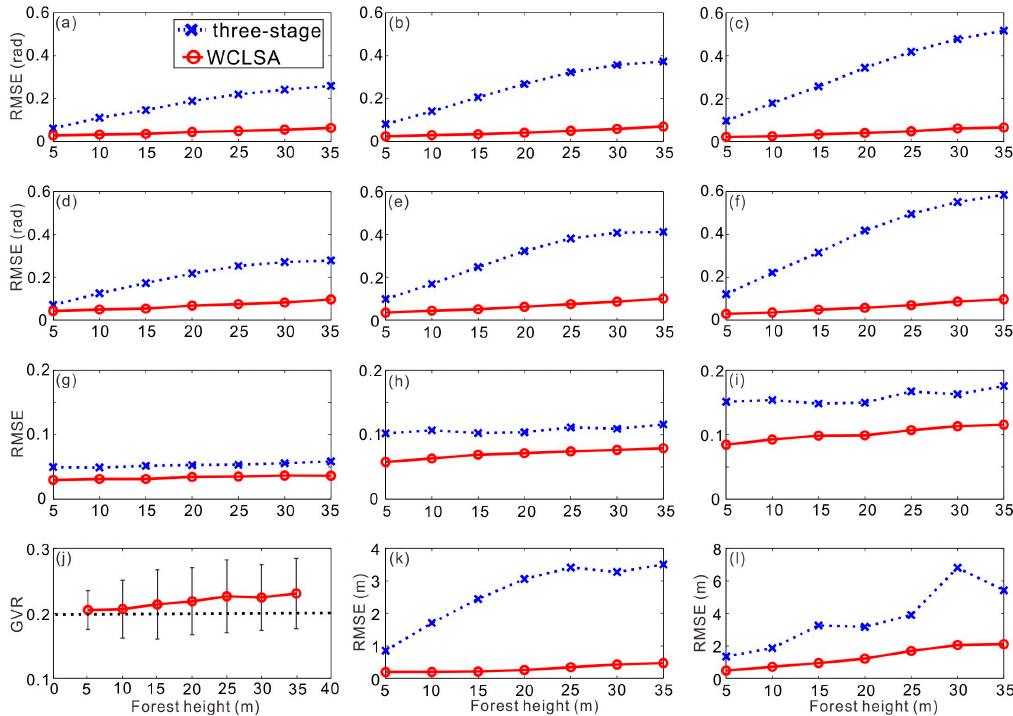
Figure 4. Solutions derived by three-stage and WCLSA: ( a – c ) root mean square errors (RMSEs) of ground phases associated with the three baselines; ( d – f ) RMSEs of phases; ( g – i ) The magnitudes of pure volume coherences (PVCs); ( j ) GVR estimates and the corresponding RMSEs (error bar); and ( k , l ) RMSEs of the forest underlying digital elevation model (FUDEM) and forest height.